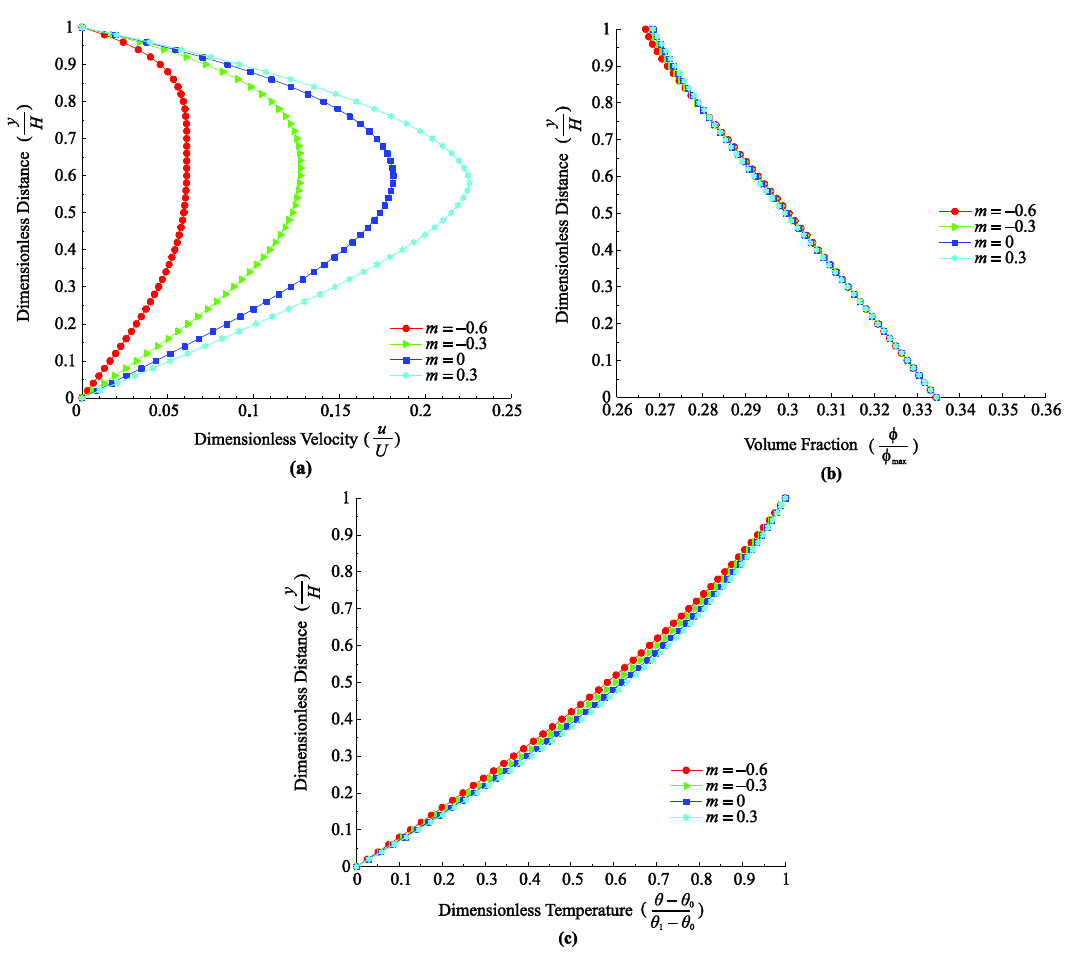
Figure 4. ( a ) Effect of m on the dimensionless velocity distribution. ( b ) Effect of m on the volume fraction distribution. ( c ) Effect of m on the temperature distribution. 𝑀 = 1, 𝐵 𝐵 = 0.01, 𝐵 = 10, 𝐵 = 0.1, 𝑇 = 1.5, 𝑁 = 0.3, 𝑅 2 3 4